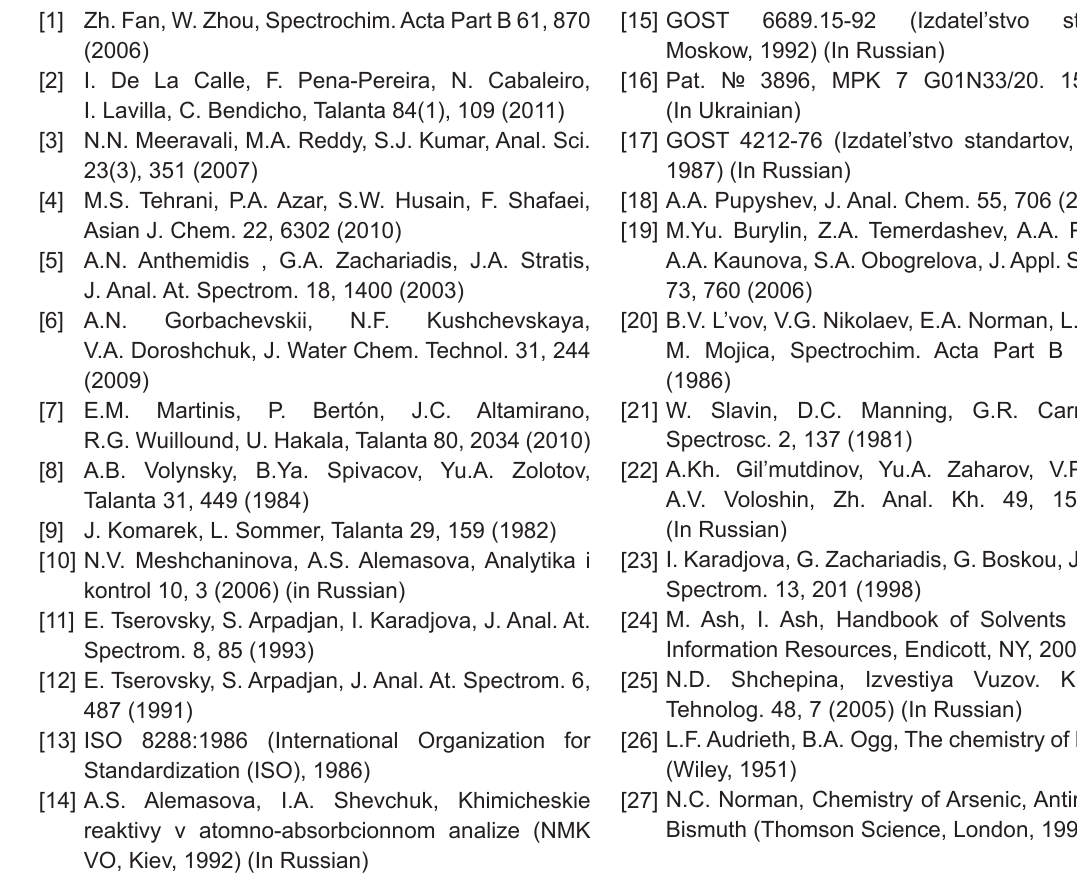
The modifier causes 2-fold sensitivity increase and 3-fold repeatability improvement of Sb determinations in comparison with non-modified